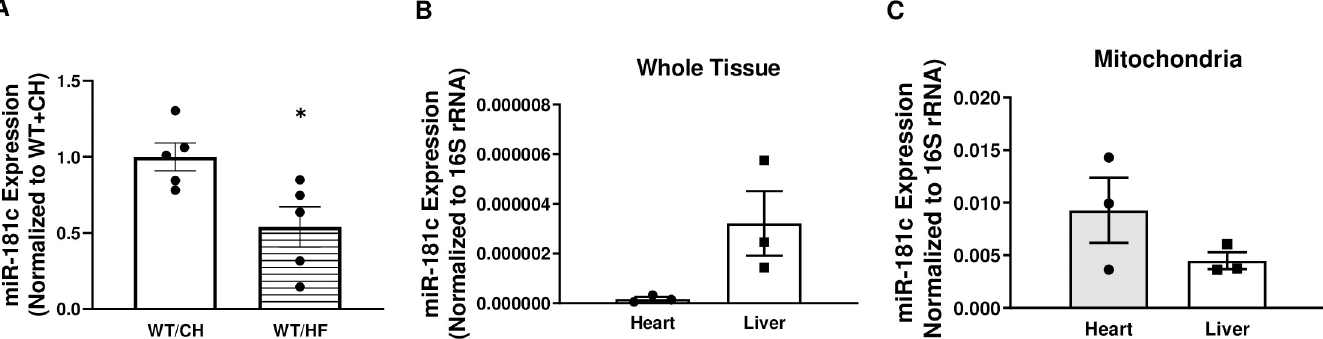
Fig 5. Cytosolic localization of miR-181c in the liver. Quantitative polymerase chain reaction (qRT-PCR) analysis of miR-181c expression in total RNA from the liver of normal chow (CH)-fed and high-fat (HF)-fed WT mice (A) , in total RNA from the heart and liver tissue (B) , and in the mitochondrial pellets of WT heart and liver tissue (C) . Data are expressed as mean ± SEM (n = 3-7/genotype/diet). � p < 0.05 by t-test analysis after intergroup differences were found by 2-way ANOVA. � p < 0.05 by two-sample t-test.